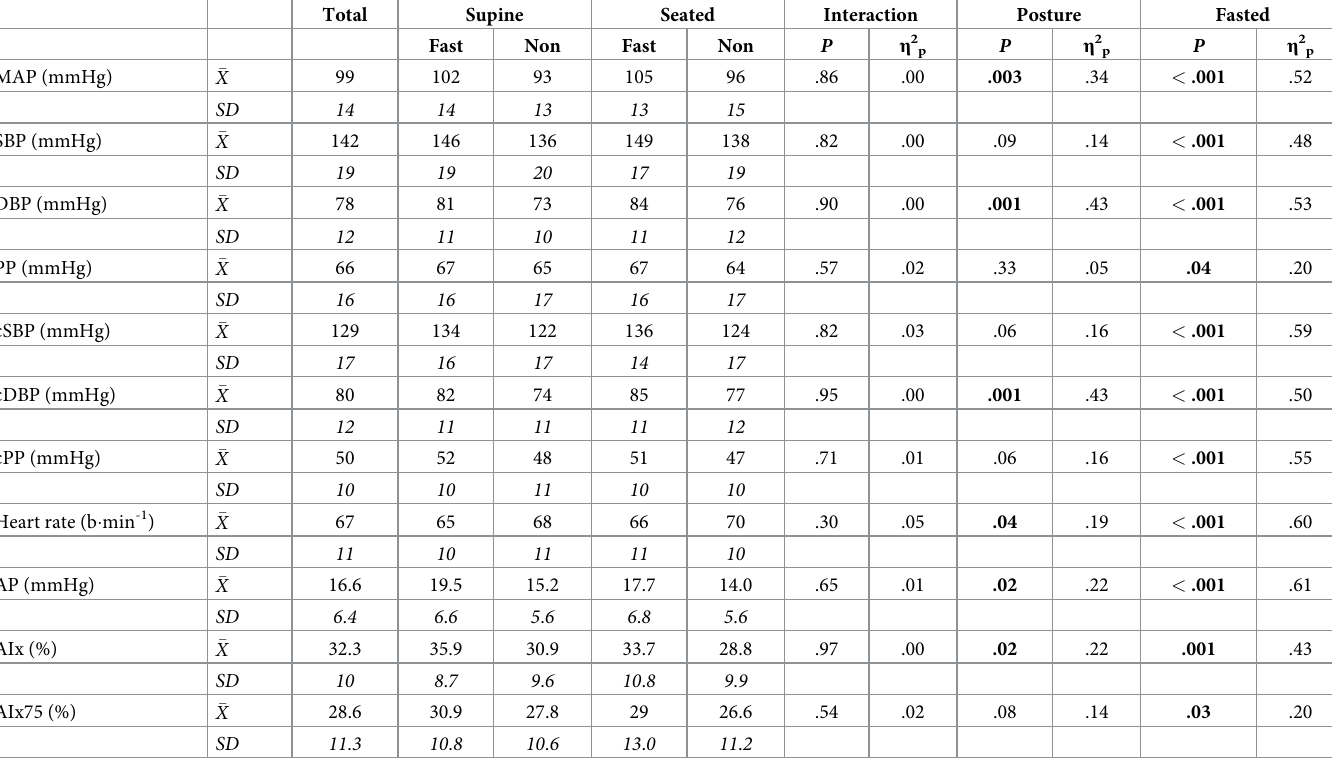
Table 3. Mean and SD for peripheral and central haemodynamic